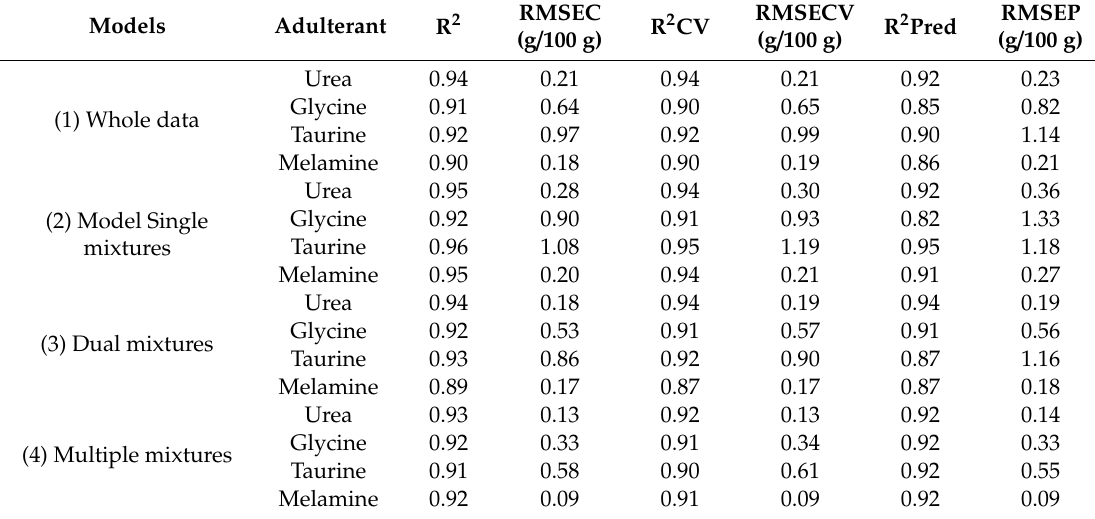
Table 1. Partial least square regression (PLSR) models for adulterated whey protein powder samples scanned with the benchtop spectrometer and analyzed at the spectral range of 950–1650 nm. Models